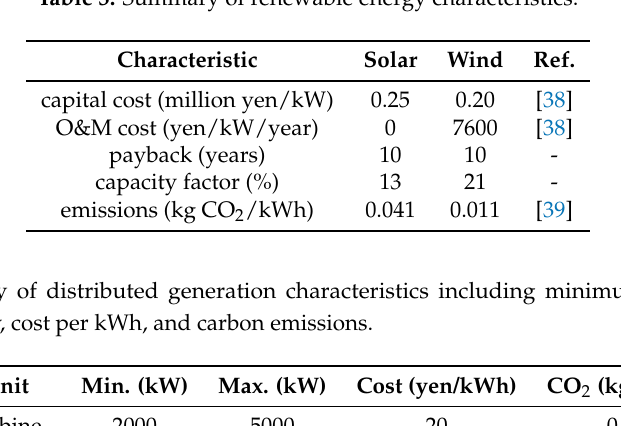
Table 3. Summary of renewable energy characteristics.